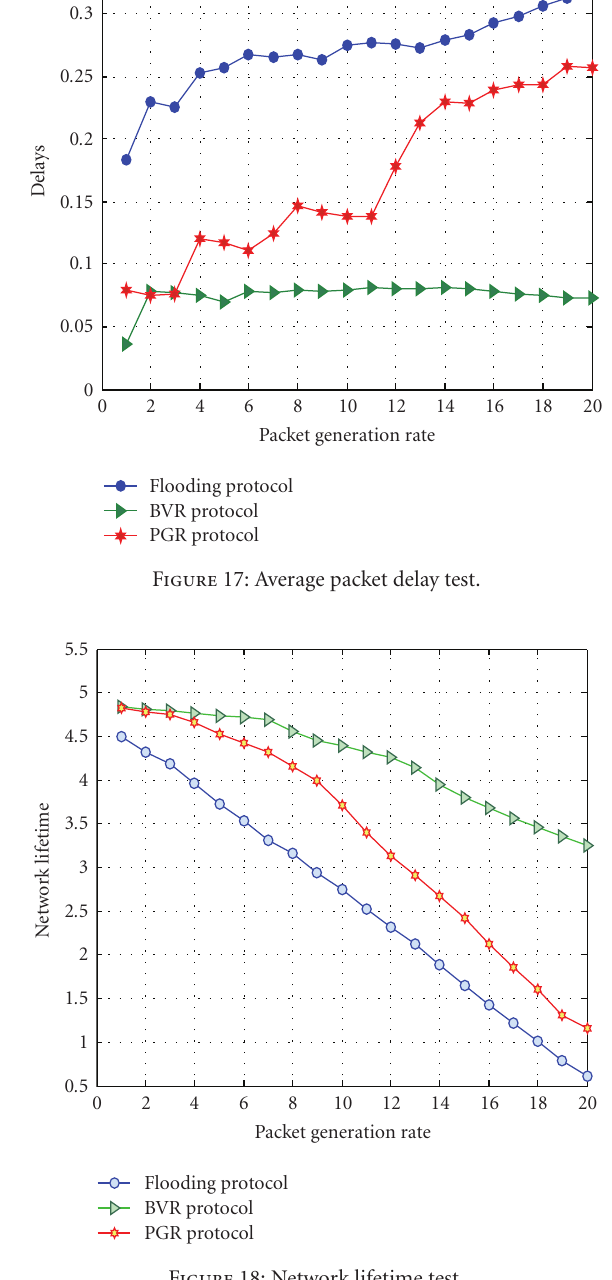
Figure 18: Network lifetime